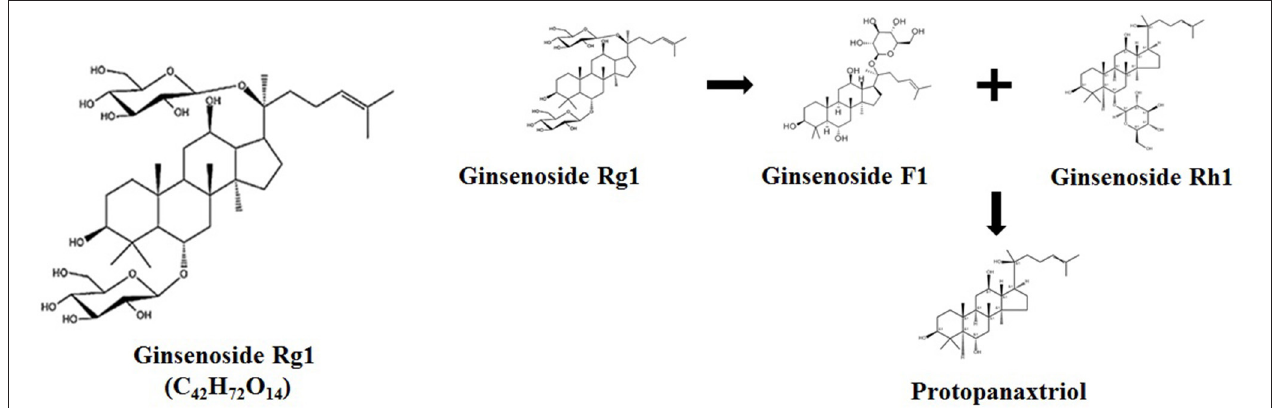
FIGURE 1 | Chemical structure of Rg1 (C42H72O14) and its potential metabolic